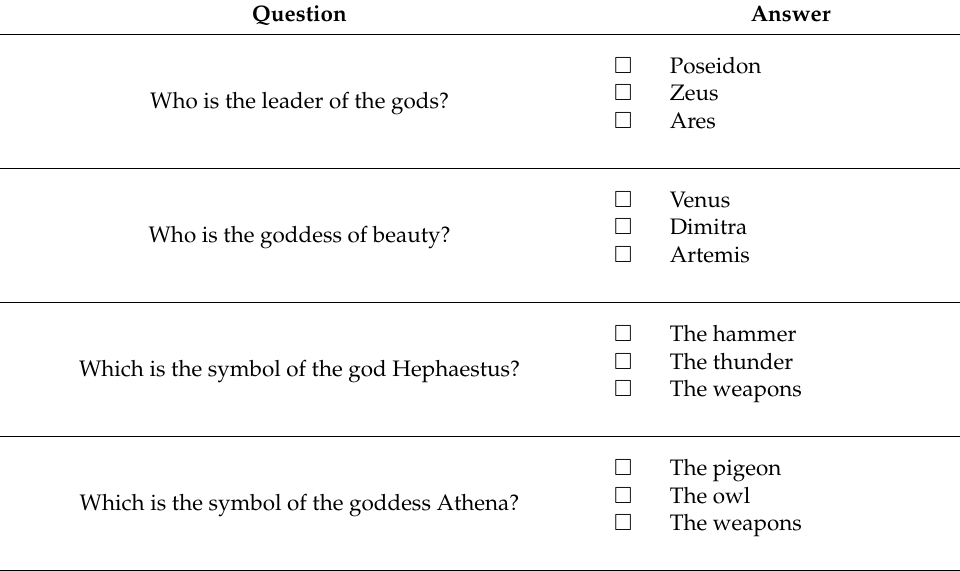
Table A1. Sample pre-/post-test